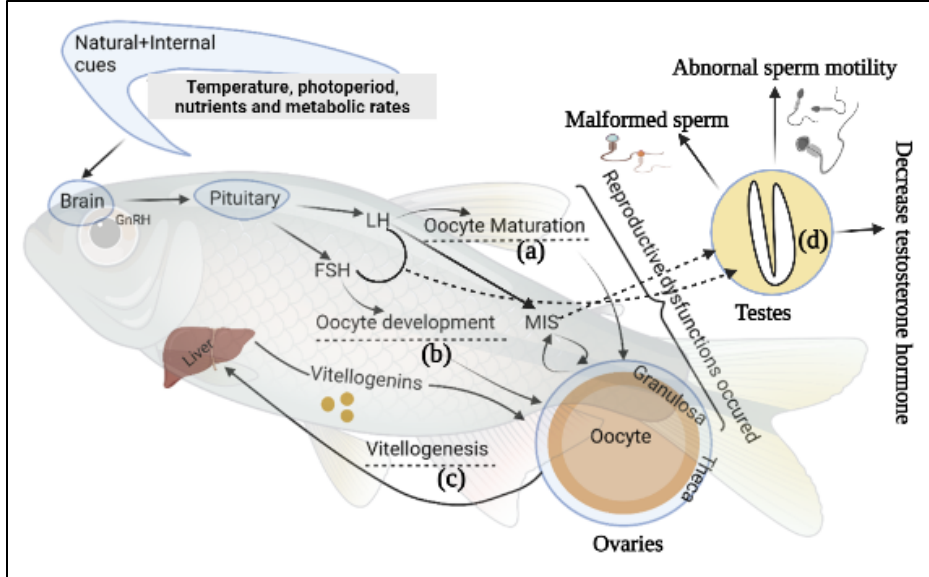
Figure 1. Schematic representation of the reproductive system and gonadal dysfunctions of fish. The broken line indicates the reproductive developmental stages. These dysfunctions may occur: ( a ) Lack of effectivity of luteinizing hormone (LH) for oocyte maturation; ( b ) outreaching of follicle-stimulating hormone (FSH) for oocyte development; ( c ) lower or no production of vitellogenin from the liver; ( d ) malformation of sperm and its motility, lowered testosterone to the testis. GnRH: gon- adotrophin releasing hormone, MIS: maturation-inducing steroid.